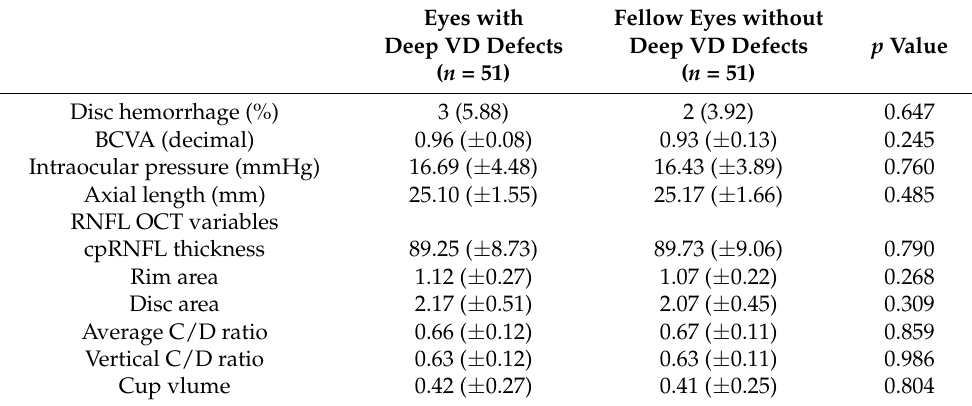
Table 2. Comparisons between eyes with deep VD defects and fellow eyes without deep VD